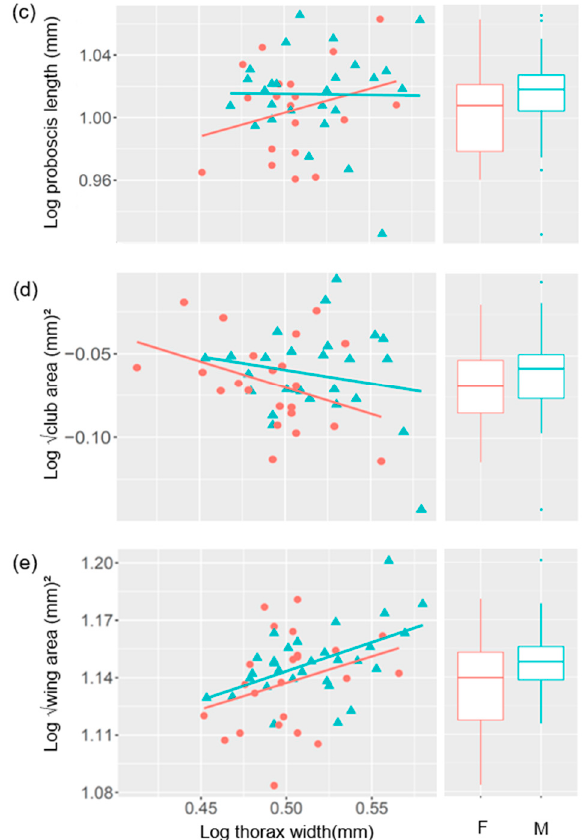
Figure 1. Sensory trait size in Pieris napi : allometric scaling relationships and summary box plots of ( a ) eye area, ( b ) antennal length, ( c ) club area, and ( d ) wing area in females (red circles) and males (blue triangles). Values on both the x and y axes are log10 transformed.